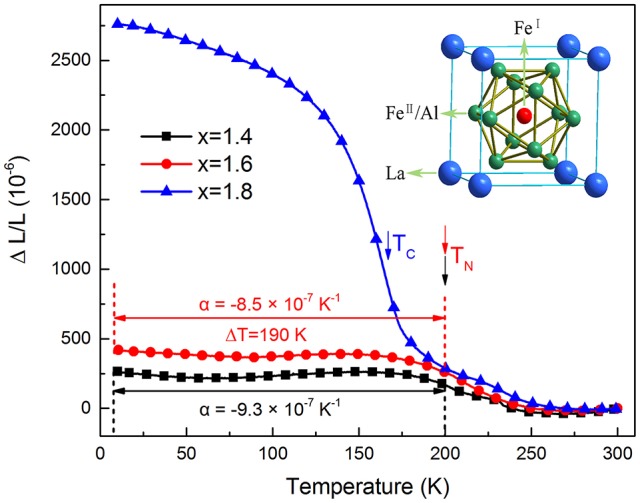
Temperature dependence of linear thermal expansions ΔL/L (reference temperature: 300K) of LaFe13−xAlx.